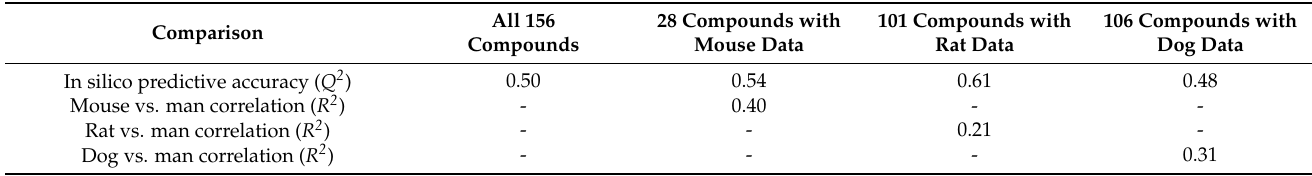
Table 1. Correlations between predicted oral bioavailability (forward-looking in silico predictions) and observed oral bioavailability in animal models (mouse, rat and dog) vs. observed oral bioavailability in man for 156 compounds.